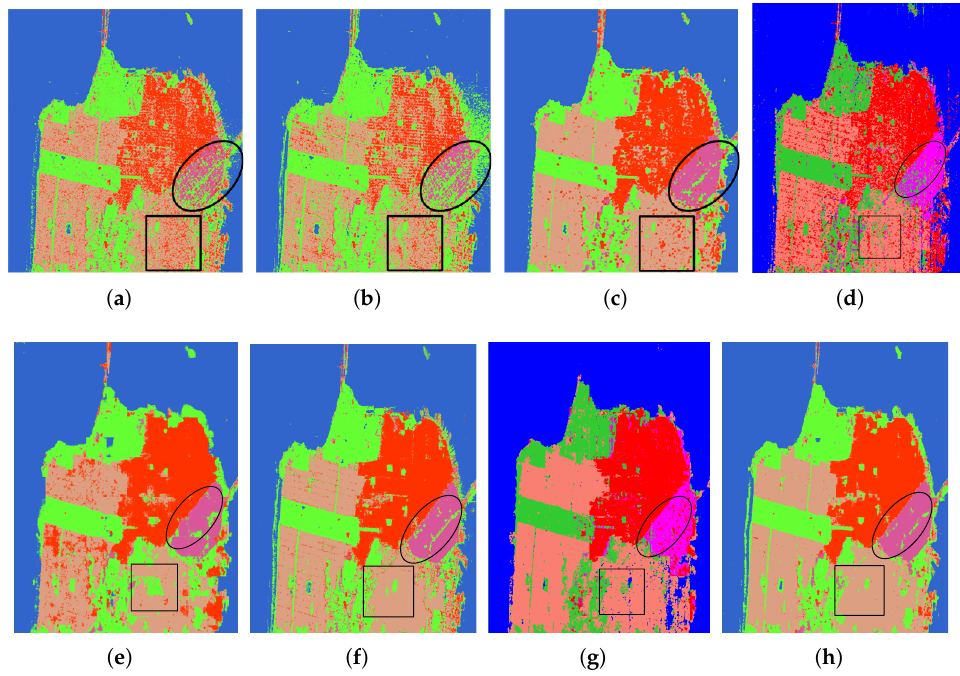
Figure 10. Classification results of the San Francisco dataset with different methods. ( a ) SVM.